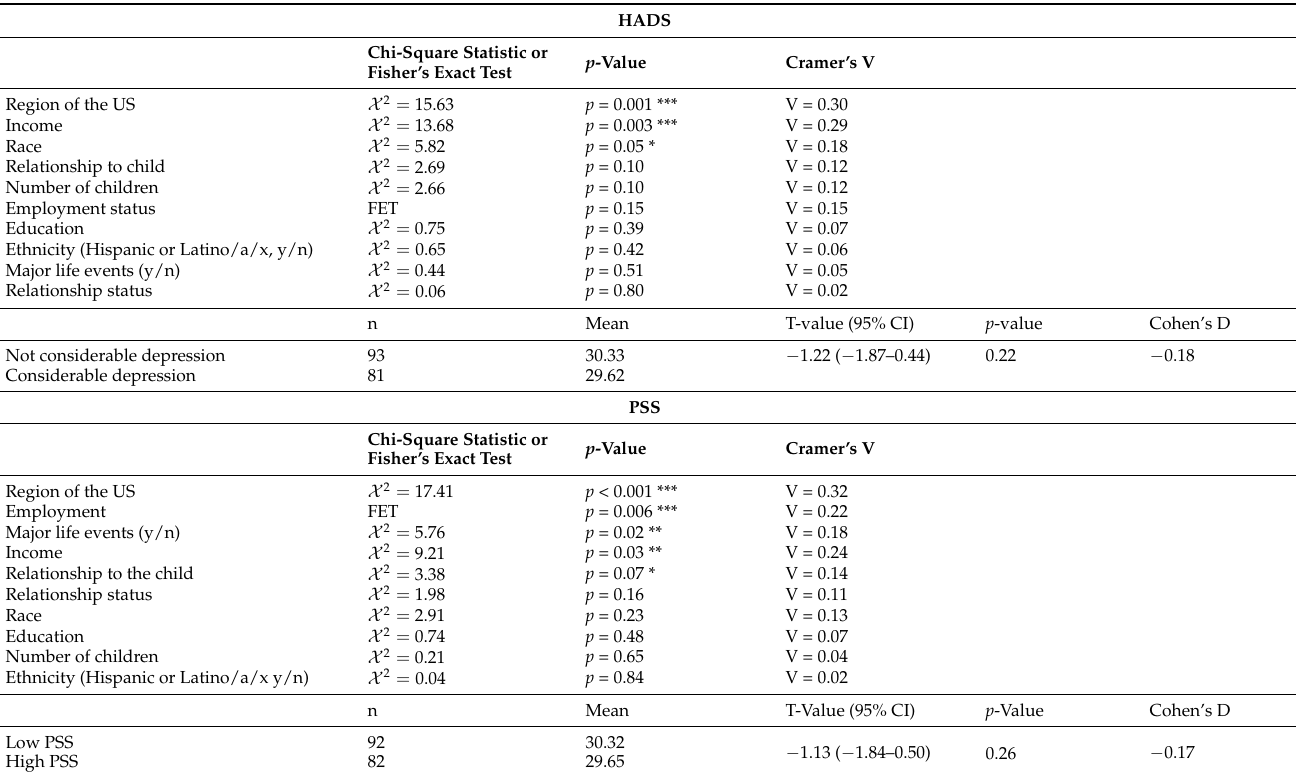
Table 2. Results of bivariate analyses for the association between covariates and HADS/PSS out- comes.